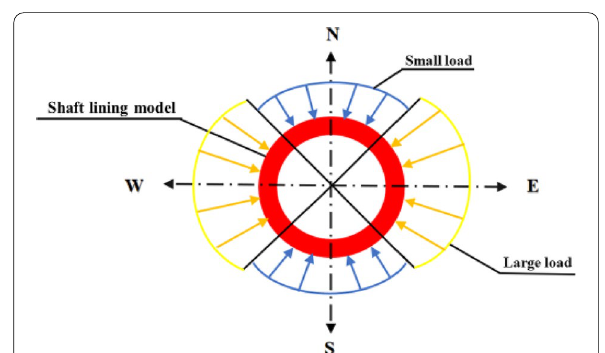
Fig. 13 Load distribution of the shaft wall model